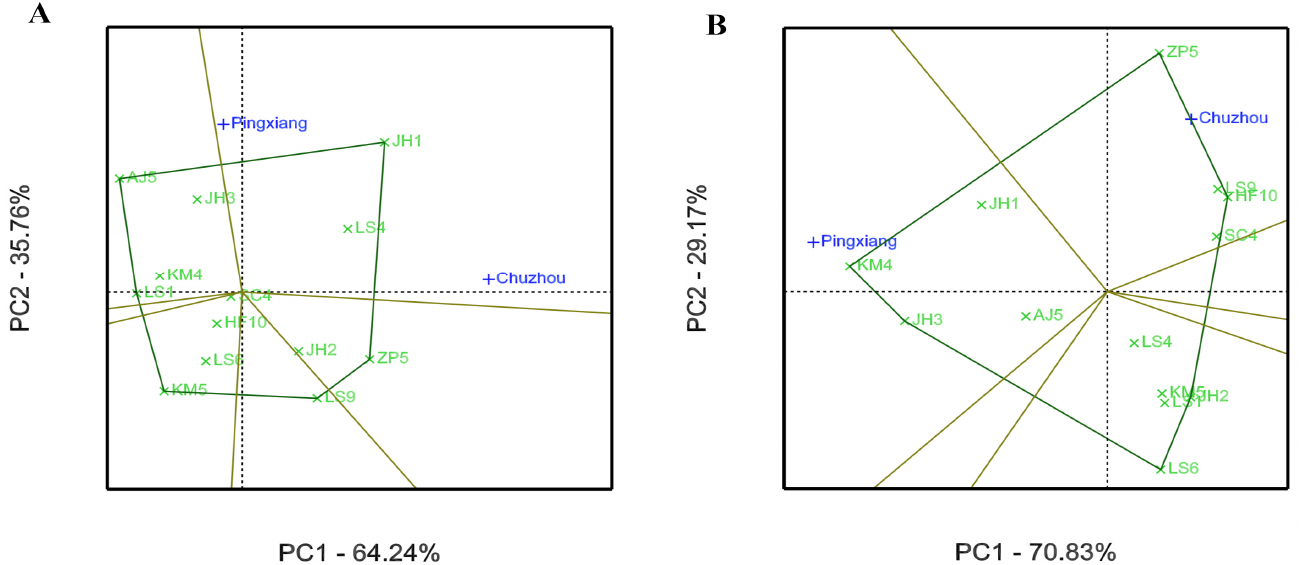
Figure 4. Polygon views of the GGE biplot based on symmetrical scaling for the which-won-where pattern for the leaves of C. paliurus genotypes evaluated for total flavonoid content ( A ) and total triterpenoid content ( B ).